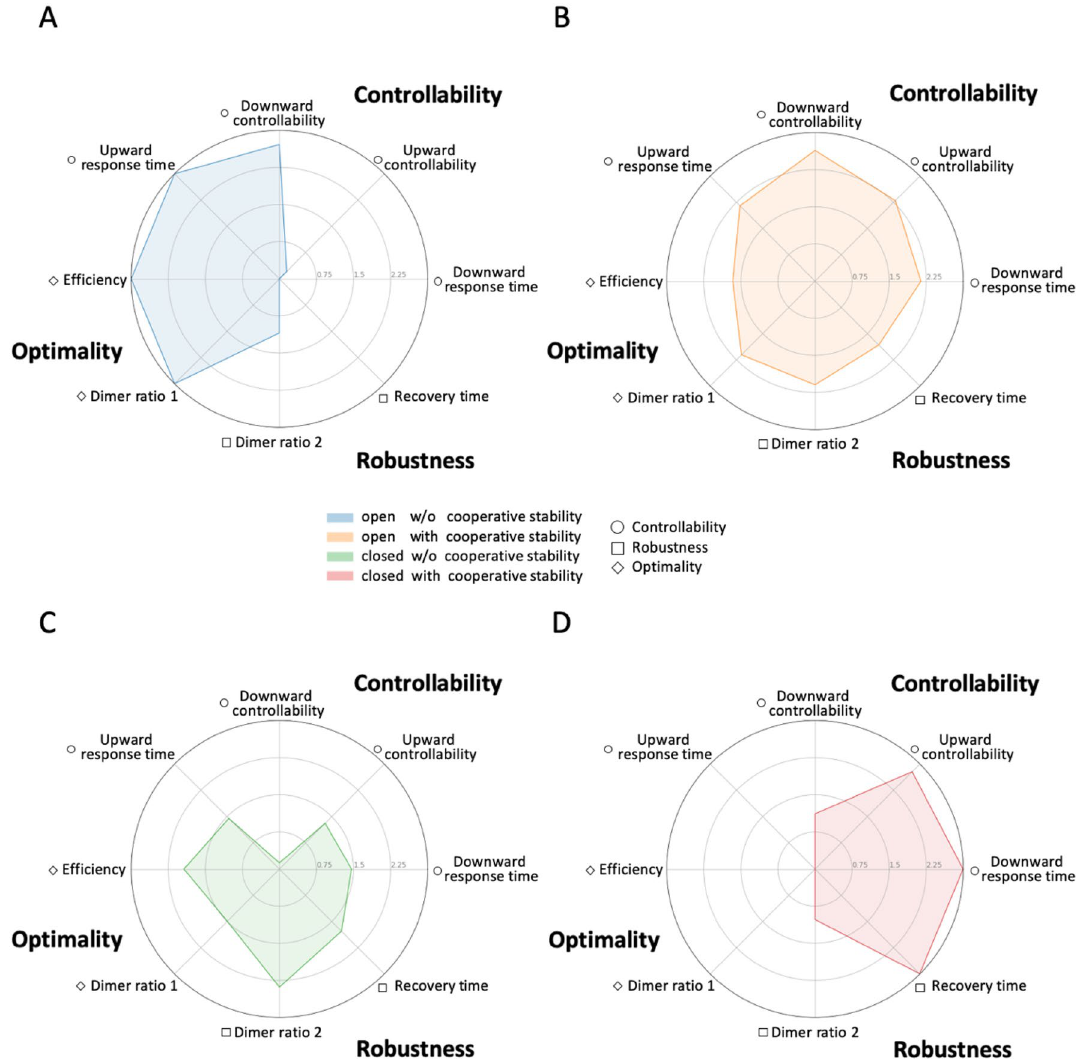
Figure 4. Circuit performance according to multiple design characteristics. Radar charts representing the relative performance of each circuit according to eight characteristics across the parameter space. The score is the result of multiple comparison between a given circuit and the other three circuits. The eight characteristics are grouped into three categories: (1) Optimality [Efficiency and Dimer ratio 1 (stoichiometrically balanced)], denoted by diamonds; (2) Robustness [(Dimer ratio 2 (stoichiometrically imbalanced)) and Recovery time]], denoted by squares; and (3) Controllability [Upward/Downward controllability and Upward/Downward response time], denoted by circles. ( A ) Circuit 1 (open loop without cooperative stability) (blue). ( B ) Circuit 2 (open loop with cooperative stability) (orange). ( C ) Circuit 3 (negative feedback loops without cooperative stability) (green). ( D ) Circuit 4 (negative feedback loops with cooperative stability)